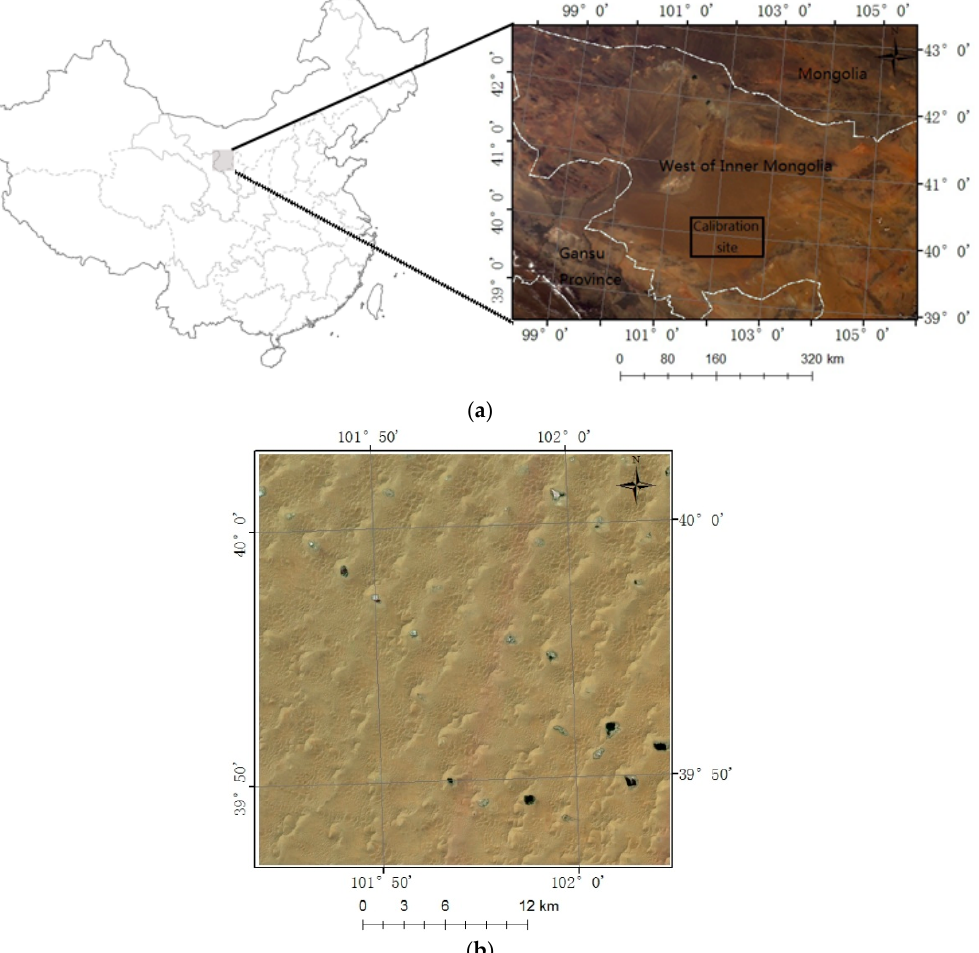
Figure 2. Location and close view of the calibration site: ( a ) is the location of the calibration site and a true color composite from Moderate Resolution Imaging Spectroradiometer (MODIS) imagery and ( b ) is the close view of the site from a true color composite of Landsat Enhanced Thematic Mapper Plus (ETM+) imagery.